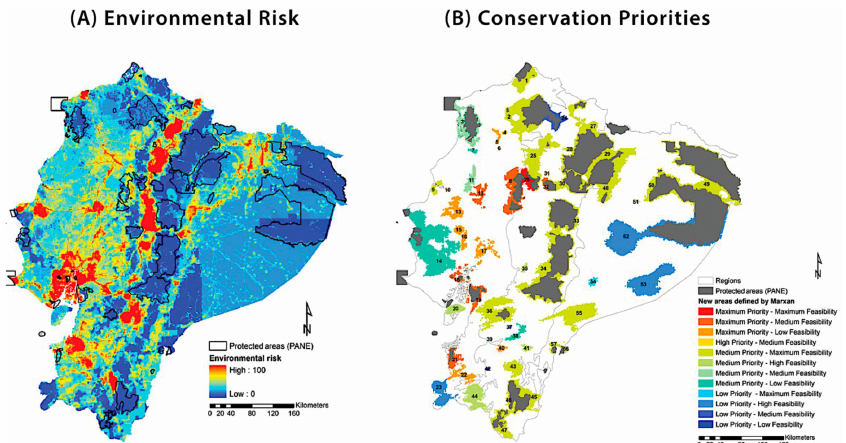
Figure 239. Environmental risk and conservation priorities in Ecuador. ( A ) Environmental risk surface forcontinental Ecuador. Thissurface takesintoaccountinformation onroads, humanpopulation density, airports, dams, agriculture and husbandry, and oil and mining industry [73]. ( B ) Conservation priorities in Ecuador; this map was constructed using the potential distribution of 809 species (amphibians, birds, mammals, plants), combined with feasibility of conservation [73].